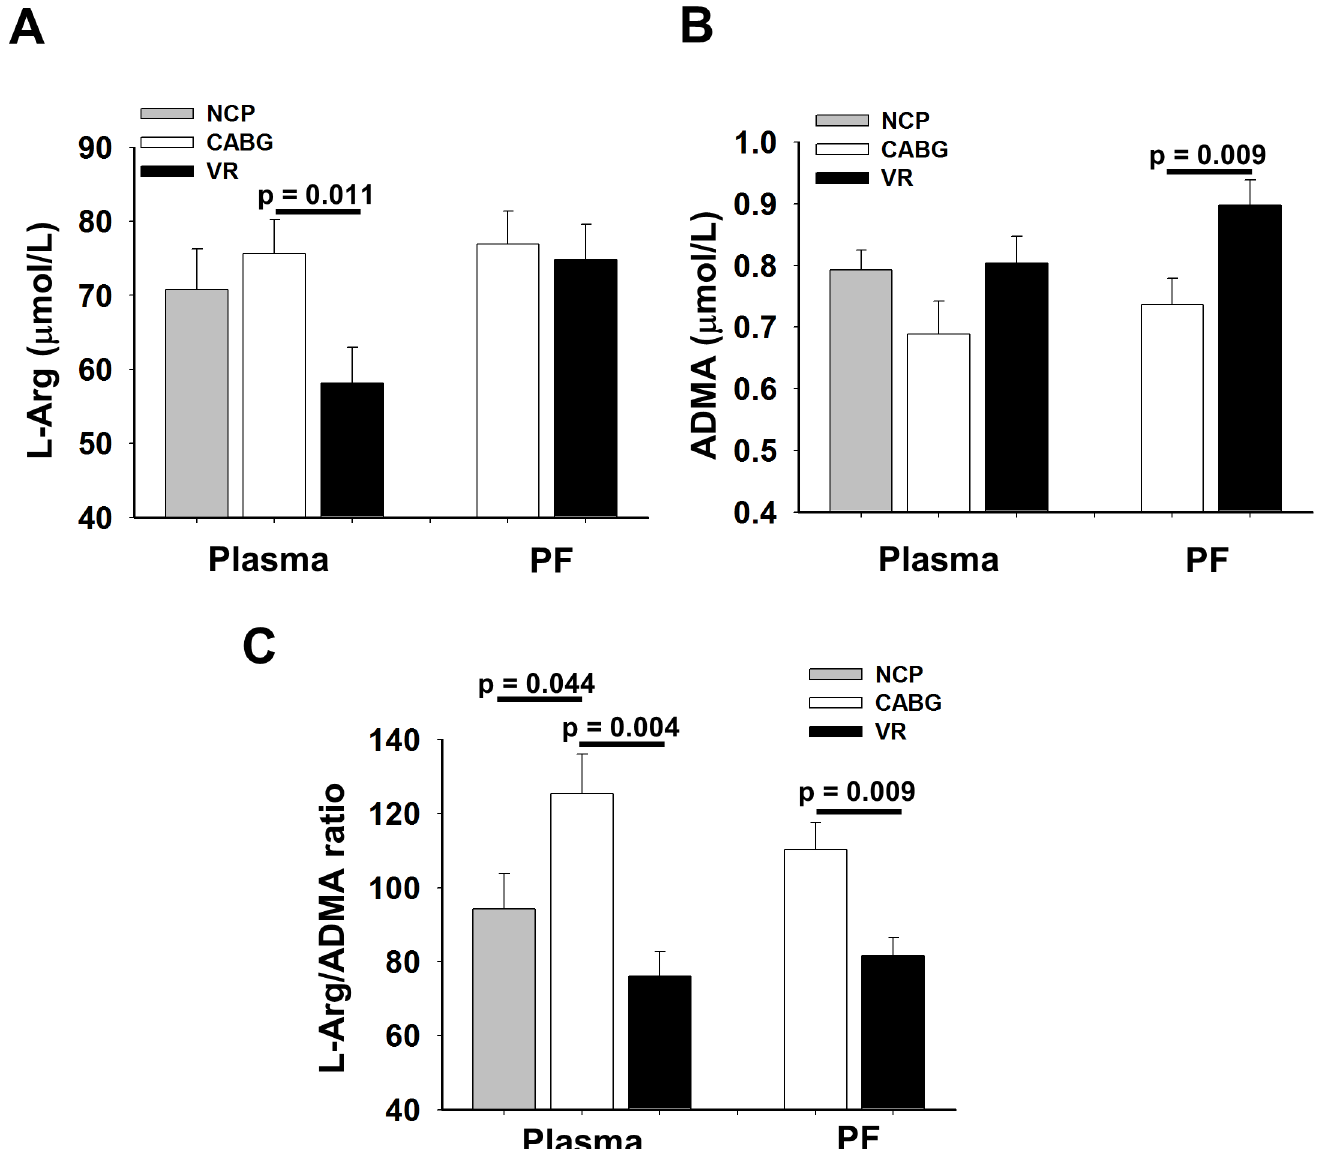
Fig 1. L-Arg and asymmetric dimethylarginine (ADMA) in plasma of non-cardiac patients (NCP) (n = 20), and in plasma and pericardial fluid (PF) of patients undergoing coronary artery bypass graft (CABG, n = 28) or valve replacement (VR, n = 25) surgery. (A) Levels of L-Arg in plasma and PF. (B) Levels of ADMA in plasma and PF. (C) ratios of L-Arg and ADMA in plasma and PF. Mean ± SEM. * indicates significant (p < 0.05) differences between CABG and VR patients. Substrate availability indicated by the ratio, which is significantly increased in CABG compared to NCP and